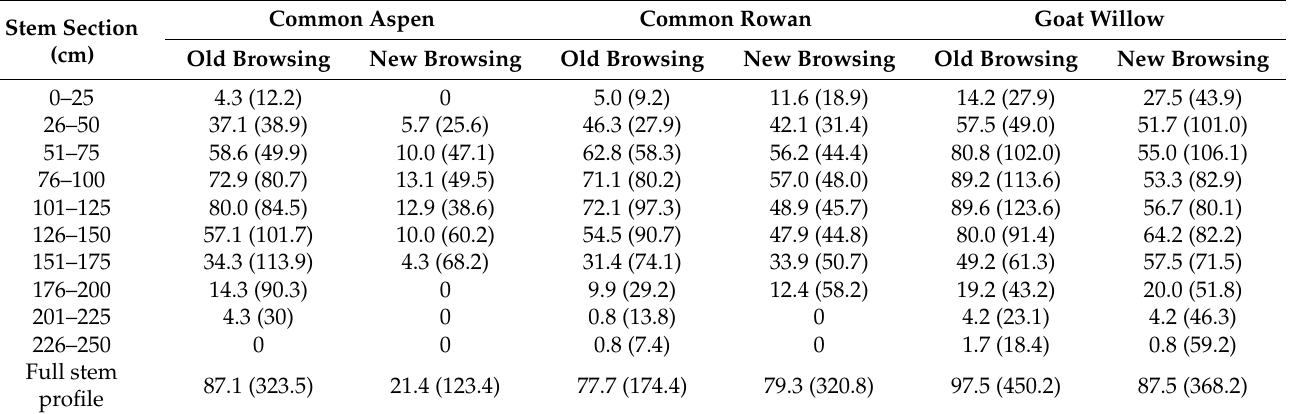
Table 2. Mean share of browsed trees on total number of measured trees (%) and mean browsed area (cm 2 , in brackets) calculated for the set of browsed trees separately for old (years 2019 and 2020) and new (year 2021) bark damage by large wild herbivores by stem section on common aspen ( Populus tremula L.), common rowan ( Sorbus aucuparia L.) and goat willow ( Salix caprea